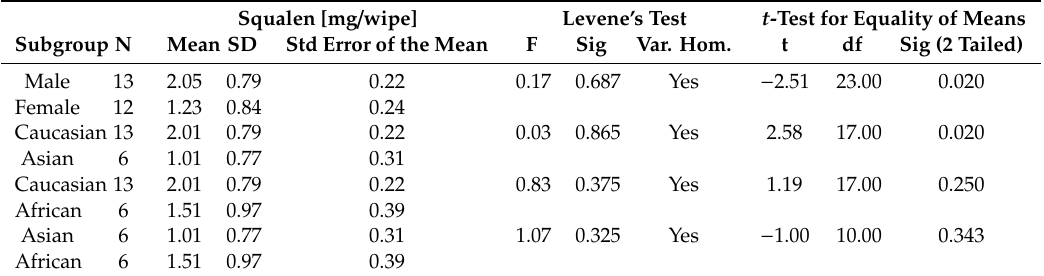
Table 3. Statistical sub-group analysis of squalene uptake by the